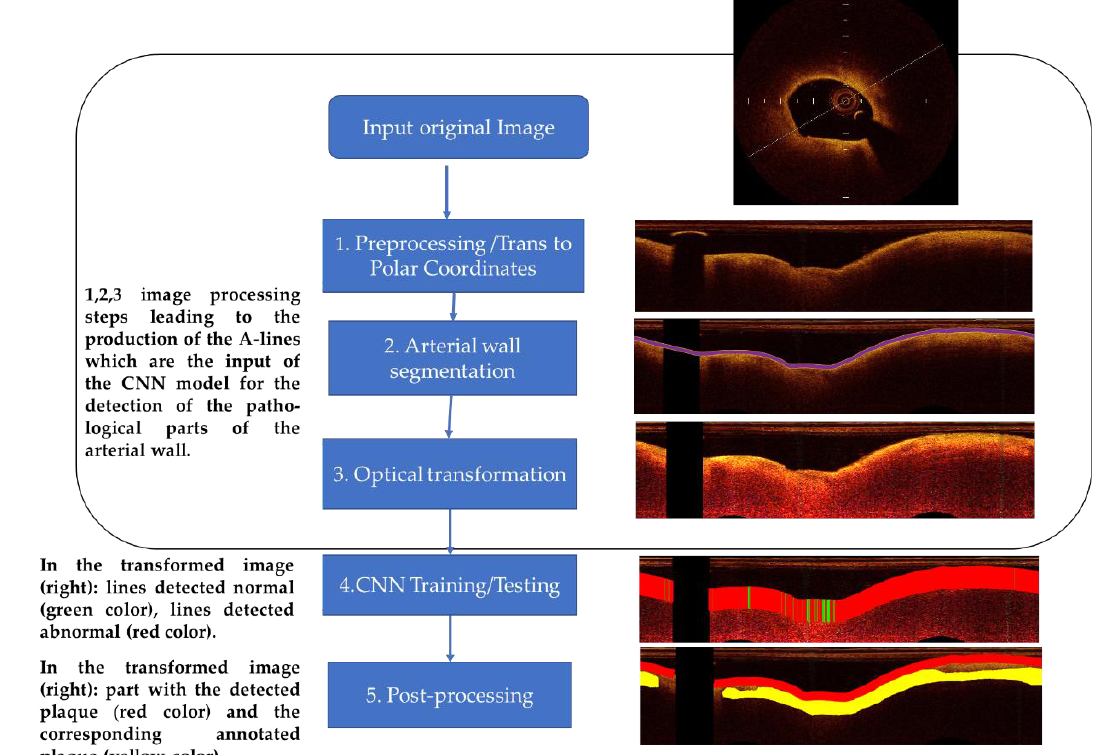
Figure 1. Methodology chart flow. Left column: The main steps of the employed image processing and CNN classification procedure. Right column: Examples of the outcomes after the implementation of each step.